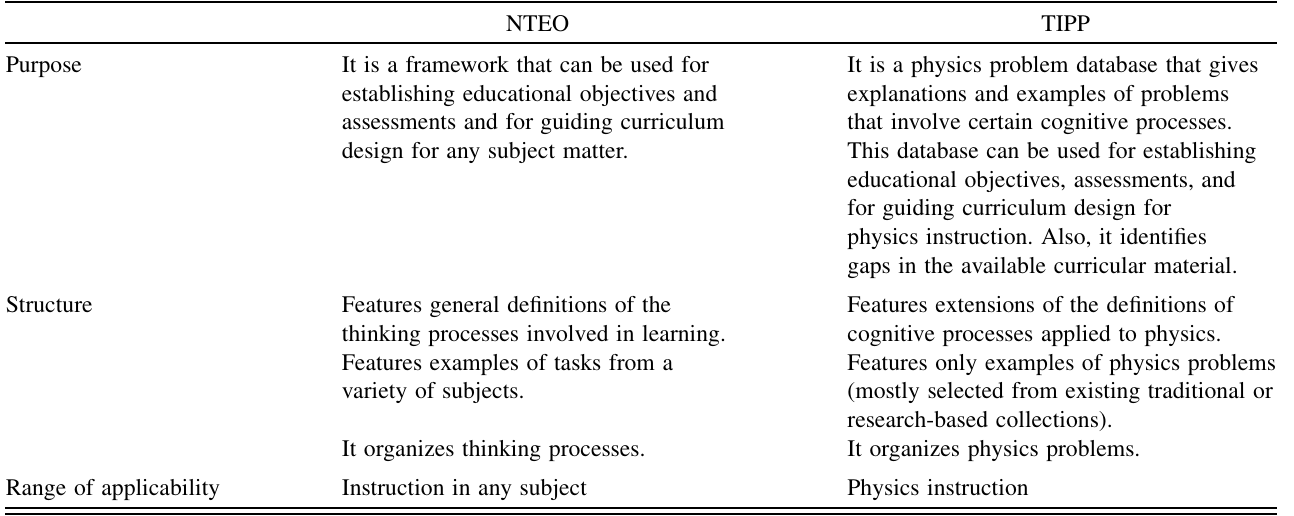
TABLE V. The differences between the New Taxonomy of Educational Objectives (NTEO) and the Taxonomy of Introductory Physics Problems